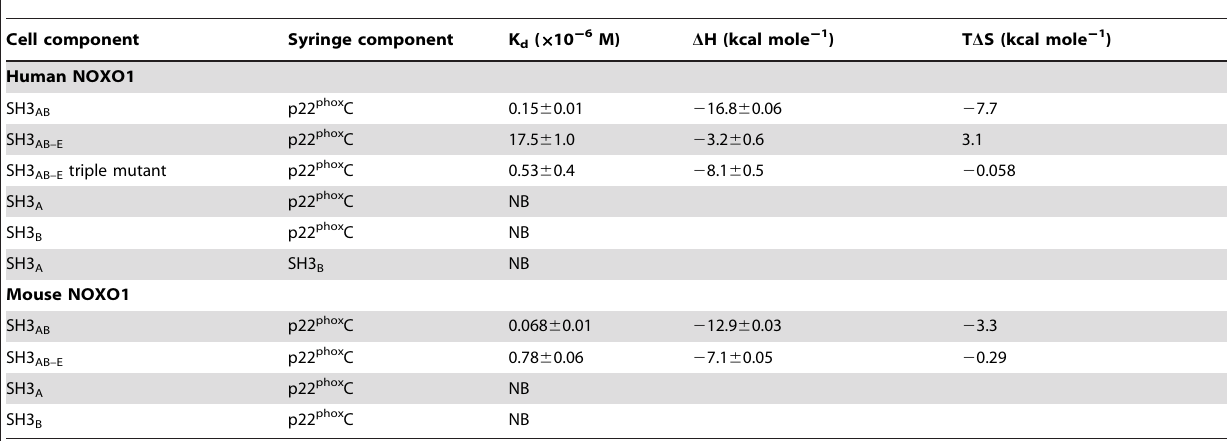
Table 1. Characterisation of intermolecular interactions between NOXO1 and p22 phox .